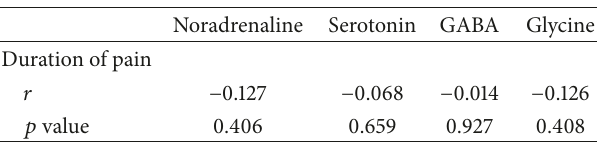
GABA, gamma-aminobutyric